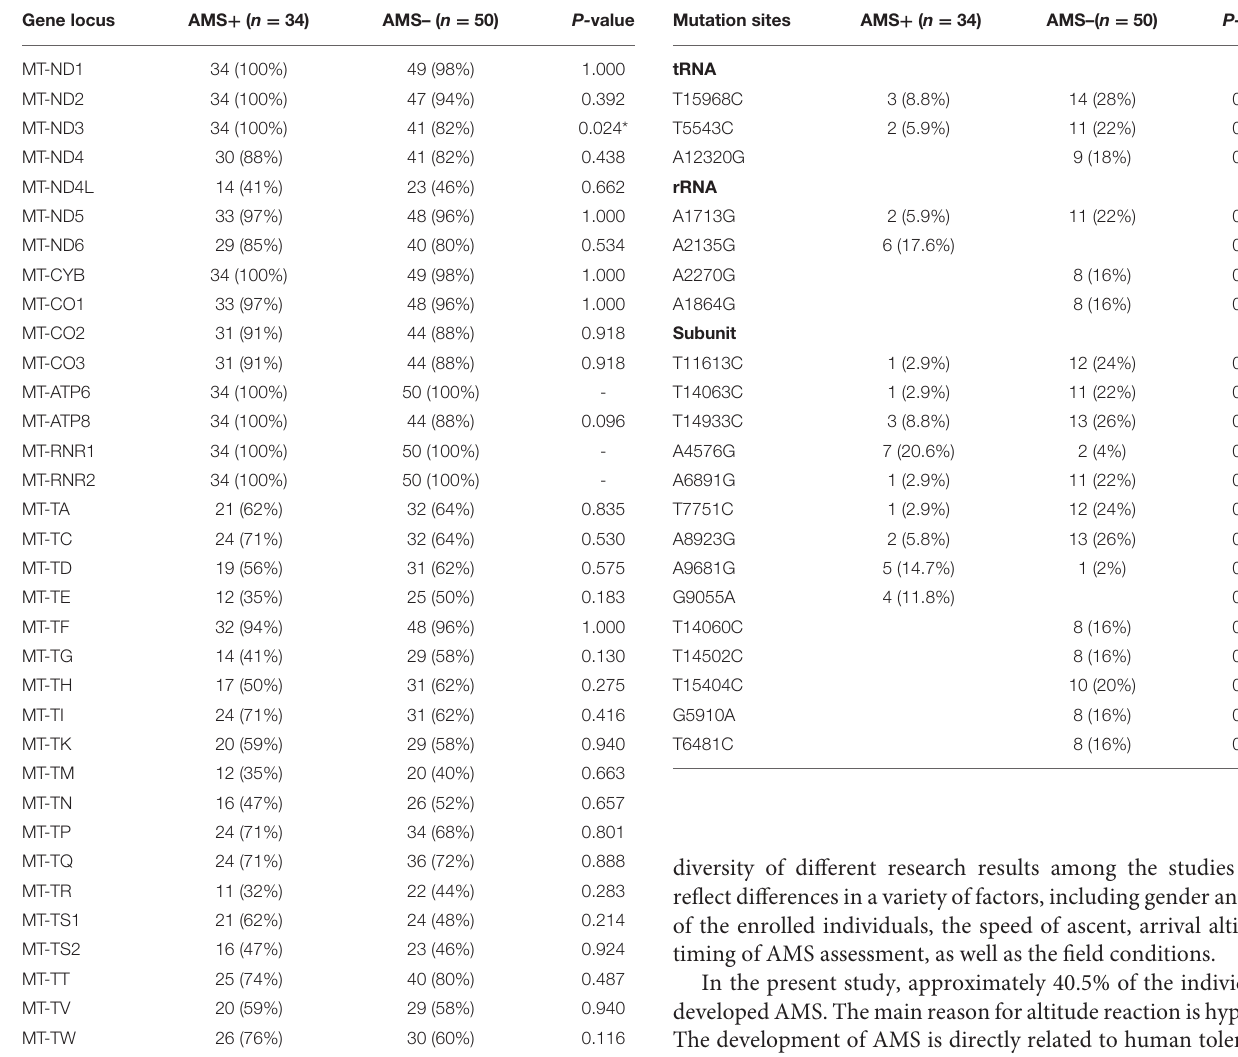
TABLE 8 | Differences in mitochondrial gene mutation sites between the two